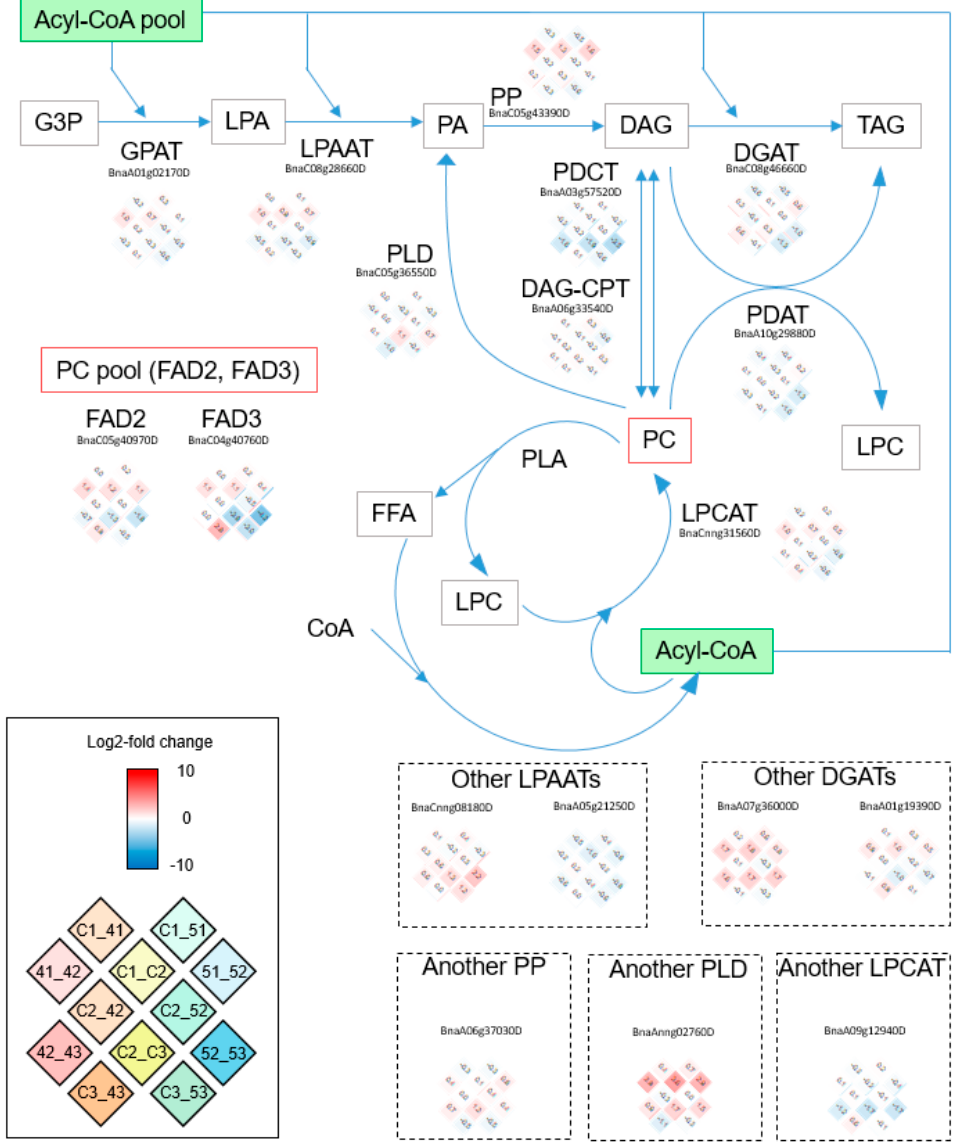
Figure 6. B. napus genes involved in triacylglycerol (TAG) synthesis and their log2-fold expression changes. As representatives of genes involved in the same biochemical step, log2-fold changes of the most highly expressed genes are shown: the expression patterns were similar among them, except those stated separately. Those showing somewhat different expression patterns are indicated in dotted boxes. Solid box: heatmap scale of log2-fold gene expression change and positions of log2-fold change for 12 pair-wise comparisons. DAG: 1,2-diacylglycerol; DGAT: acyl-CoA:diacylglycerol acyltransferase; DAG-CPT: diacylglycerol cholinephosphotransferase; FAD2: oleate desaturase; FAD3: linoleate desaturase; FFA: free fatty acid; G3P: glycerol-3-phosphate; GPAT: glycerol-3-